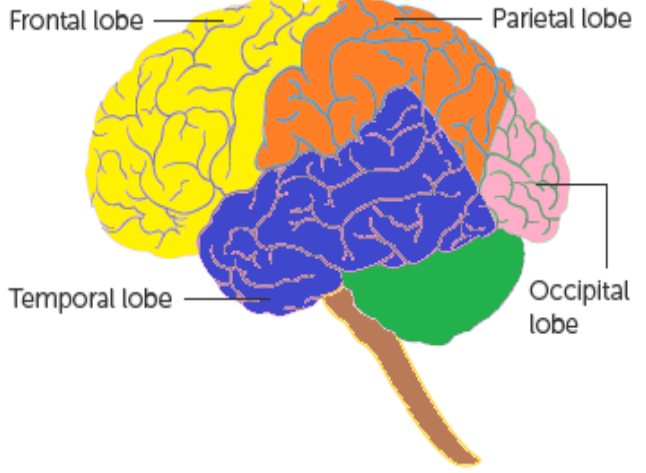
Figure 2. Classification of cerebrum (source: [39]).